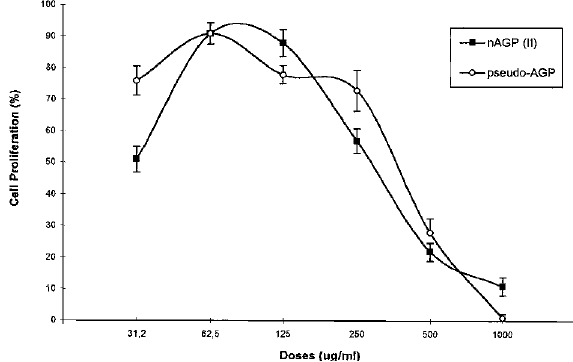
FIG. 2. Inhibition of anti-CD3 antibody-induced lymphocyte proliferation with nAGP and pseudo-AGP. For the experiment condition explanation see text and legend to Fig. 1.